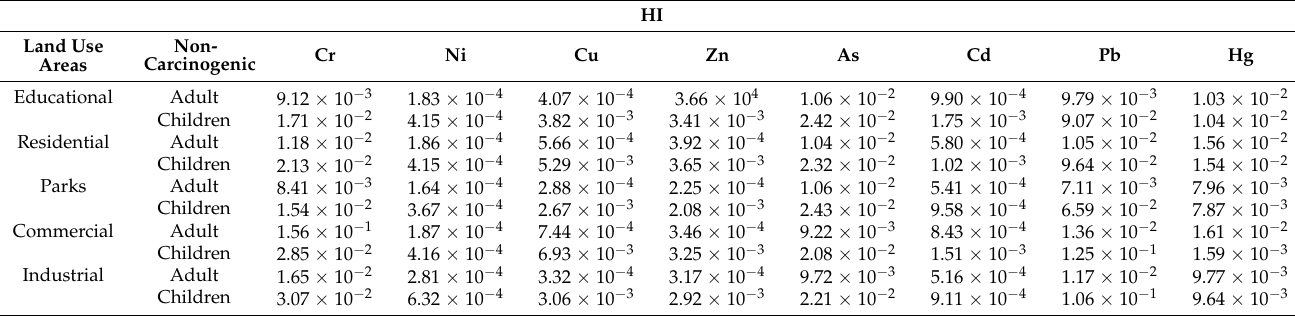
Table 8. Hazard Index (HI) values of heavy metals in different land use areas.